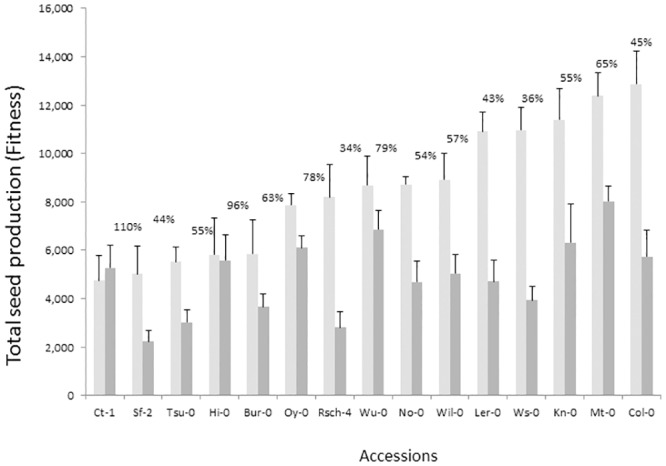
Average fitness for control (light grey) and treated (dark grey) plants for each accession.Accessions are listed in the X axis in order of their total seed production under control conditions. Numbers on the top of the bars indicate percentage of fitness maintained by inflorescence photosynthesis only (fitness maintenance).